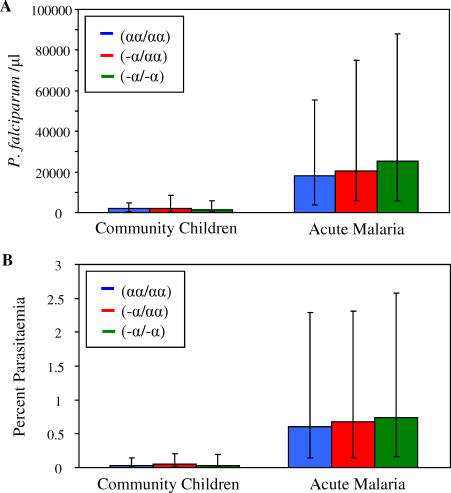
Parasite Density in Community Children and Those with Acute Malaria According to α+-Thalassaemia GenotypeParasite density is represented by (A) the number of P. falciparum-infected erythrocytes per microlitre of blood and (B) the proportion of P. falciparum-infected erythrocytes. Values are median (interquartile range). There was no statistically significant difference in parasite density or percent parasitaemia among α+-thalassaemia genotypes, in either children living in the community or those with acute malaria (p ≥ 0.3).